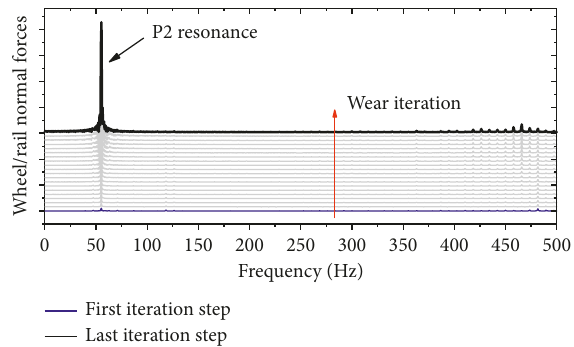
Figure 16: Frequency spectra of wheel/rail normal forces with increasing iteration step.